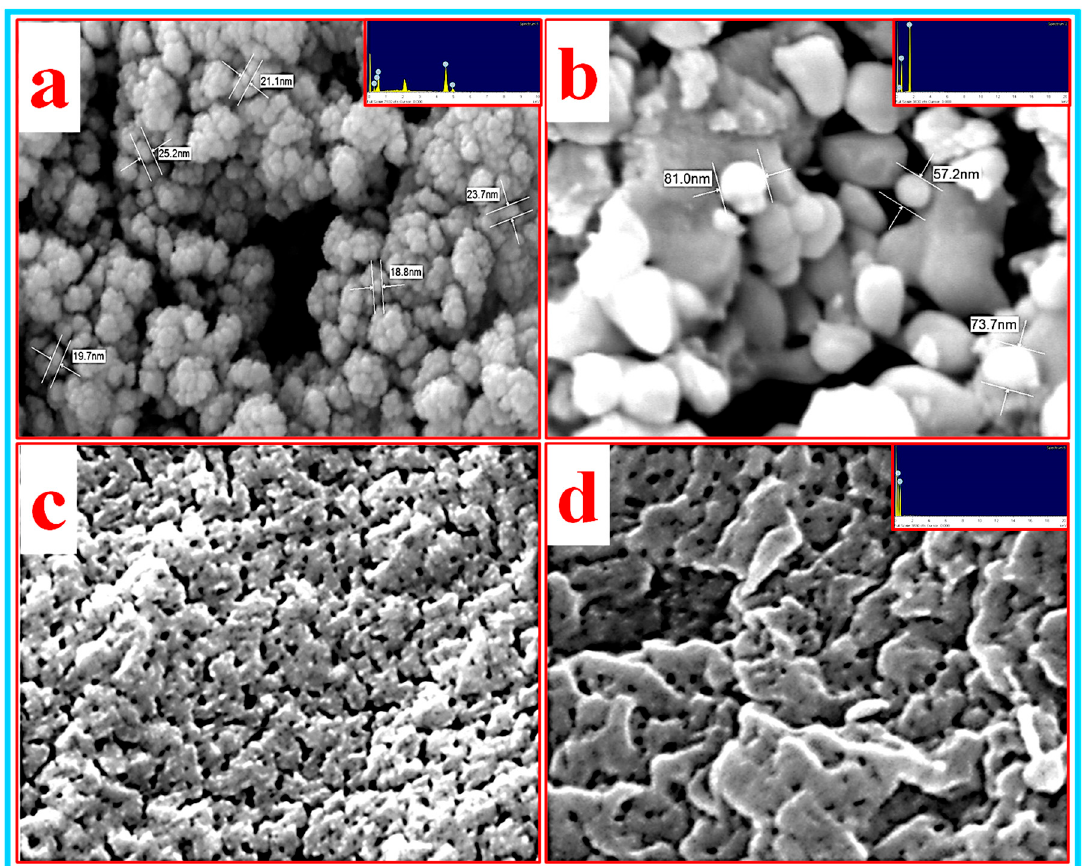
Figure 9. The FESEM micrograph of ( a ) TiO 2 and ( b ) Al 2 O 3 nanoparticles and the CNC ( c ) film and ( d ) powder at ×100,000 magnification with their respective EDX patterns (inset).